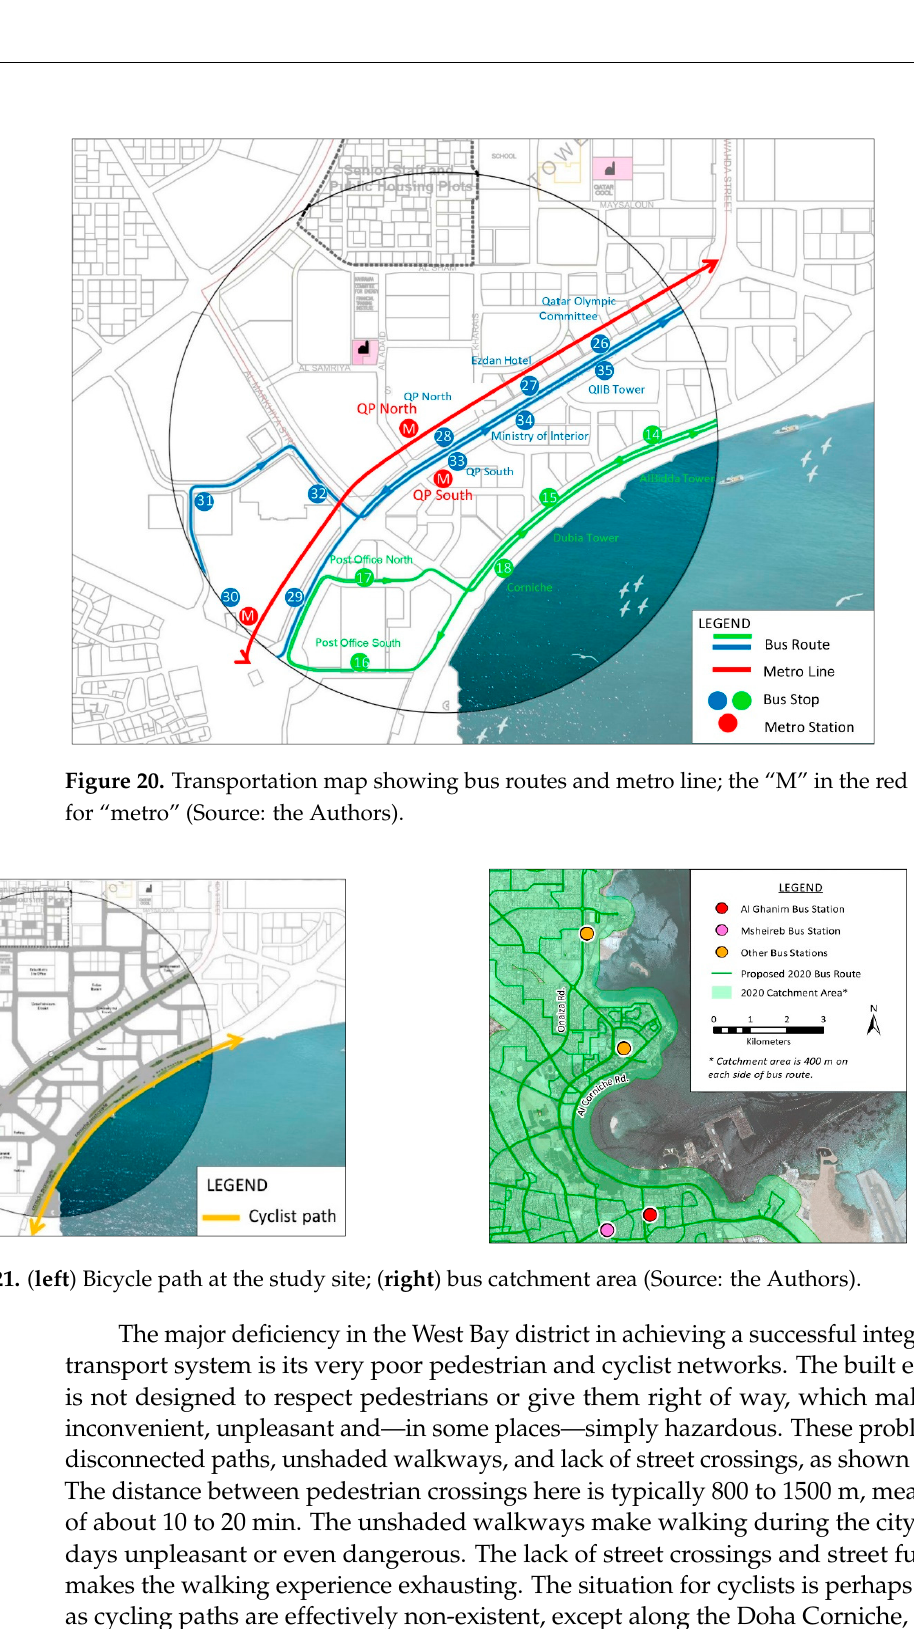
Figure 22. Illustration of poor connectivity, unshaded walkways, and lack of street crossings (Source: the Authors).